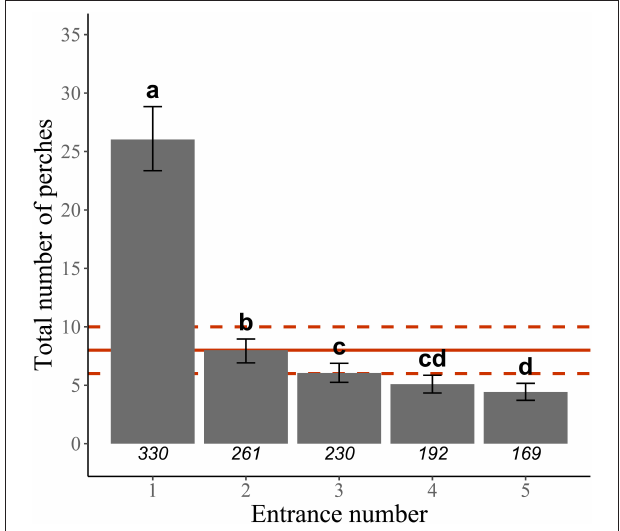
FIGURE 2 | Learning curve showing the decrease in the mean number of perches needed to solve the problem-solving task presented at the nest, i.e., to enter the nest box, over the first five entrances (data restricted to individuals that succeeded in entering the nest box at least once, i.e., solvers, and to the first learning score for individual with repeated scores across years; N = 330 individuals). Predicted means and 95% CI are represented. Bars with different letters have non-overlapping 95% CI. The red solid line corresponds to the value used for defining the learning threshold, i.e., 8 perches or less over two successive entrances (see main text), and the red dashed lines correspond to the two other values used to test the robustness of the results, i.e., 6 and 10 perches, respectively. Sample sizes (number of individuals) are given for each entrance number below each bar. See Supplementary Table 1 for